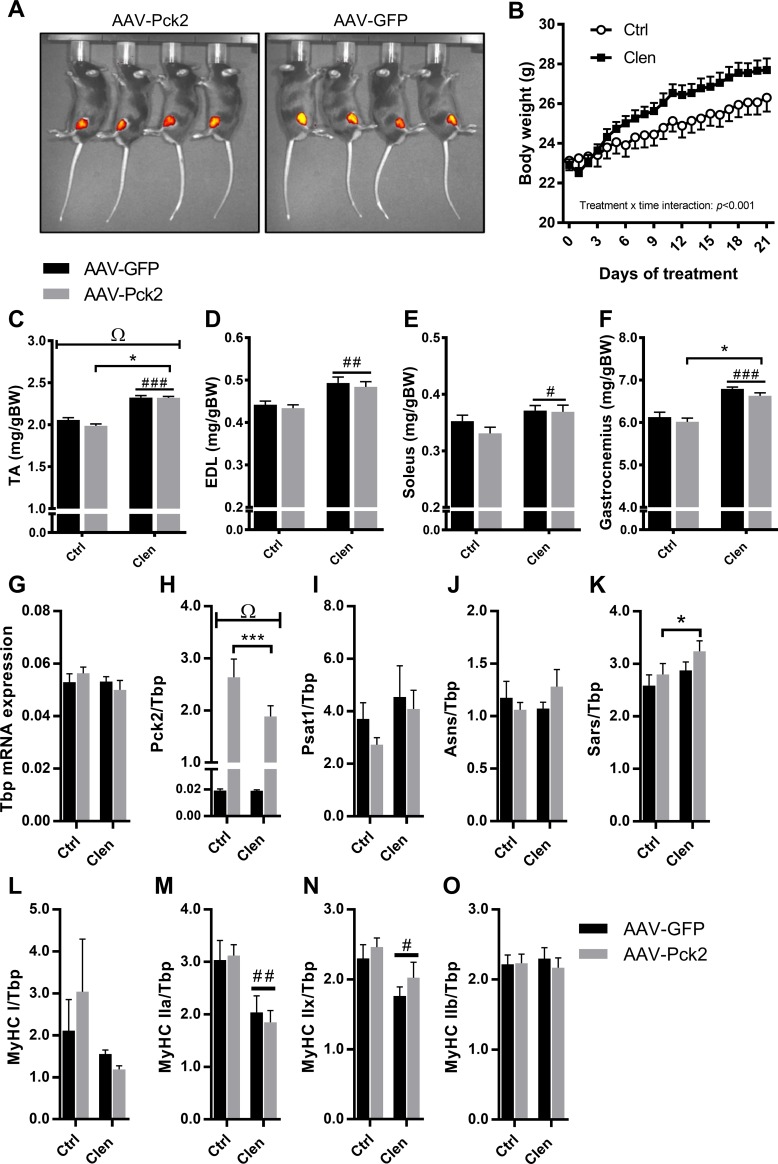
Effect of AAV-mediated Pck2 over-expression on Clenbuterol-induced muscle growth and gene xpression.(A) Representative images of GFP signal from the left and right legs of AAV-GFP and AAV-Pck2-GFP infected mice 7 days after intramuscular injection. (B) Effect of Clenbuterol (Clen) or phosphate buffered saline (Ctrl) on daily body weight starting 7 days post AAV injections (n = 8). (C-F) Effect of AAV-Pck2 on Clenbuterol mediated increases in muscle weights (Tibialis anterior, TA; Extensor digitorum longus, EDL; Soleus; Gastrocnemius; n = 8 except n = 7 for EDL Clen group). (G) TATA-box binding protein (Tbp) mRNA expression, showing no effects of AAV-Pck2 or Clenbuterol treatment. Effects of AAV-Pck2 and Clenbuterol on (H) Pck2, (I) Phosphoserine Aminotransferase-1 (Psat1), (J) Asparagine Synthetase (Asns), (K) Seryl-tRNA Synthetase (Sars) and myosin heavy chain (MyHC) types I (L), IIa (M), IIx (N) and IIb (O) mRNA expression in TA muscle. All data (except Tbp mRNA) was normalized to the reference gene, Tbp (n = 8 for all). Ω p<0.09 indicates a trend for an AAV x treatment interaction. * p<0.05 and **** p<0.001 indicate a significant effect of AAV-Pck2 compared to AAV-GFP. # p<0.05, ## p<0.01 and #### p<0.001 indicate a significant effect of Clen compared to Ctrl treated mice.